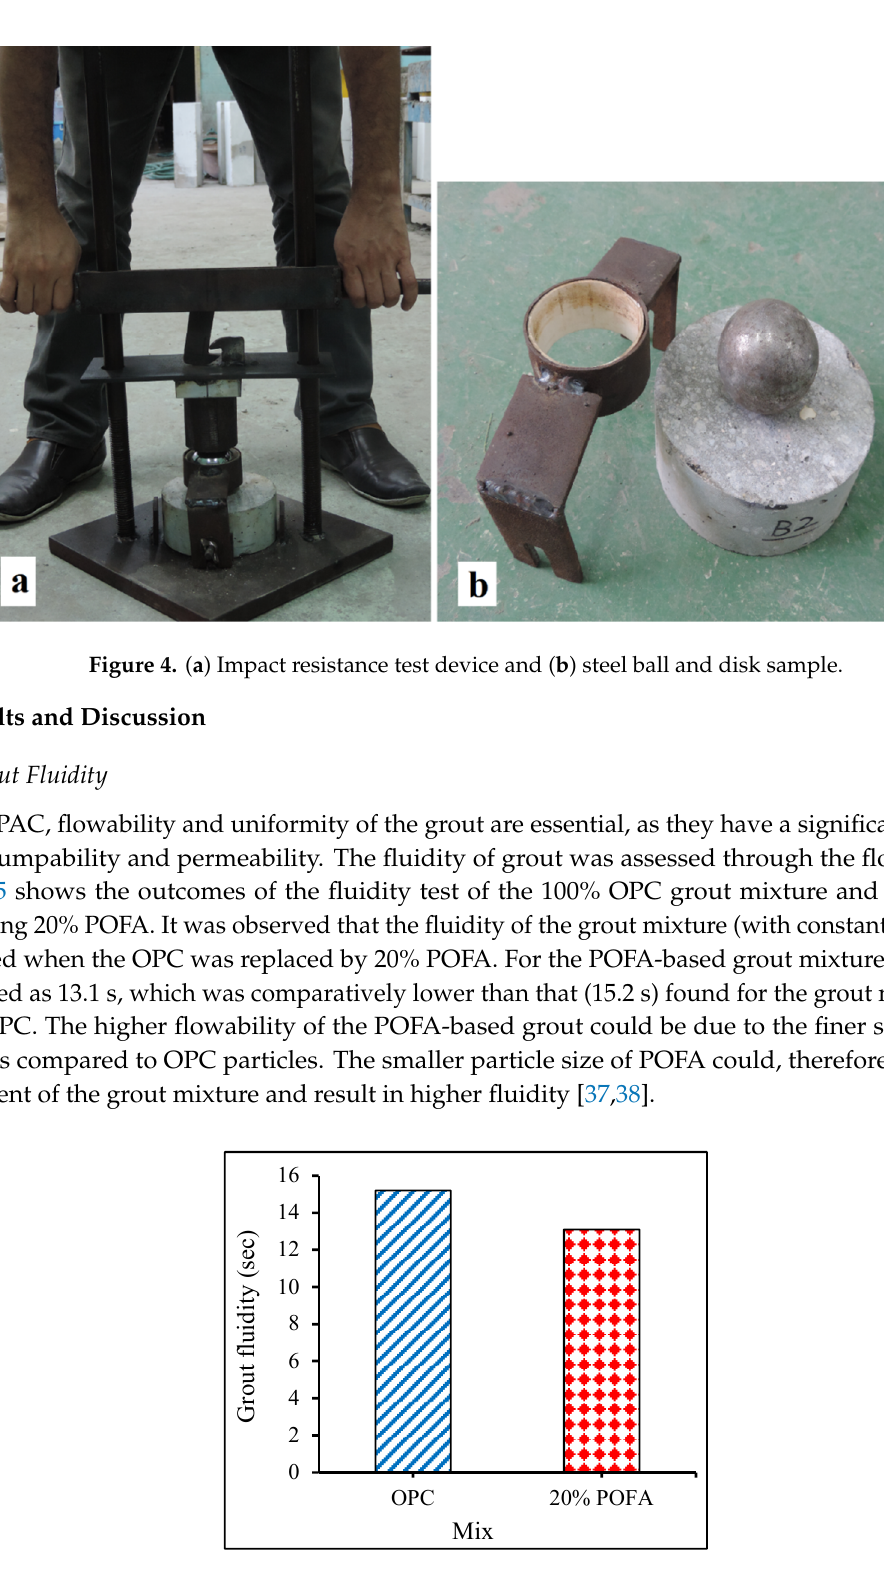
Figure 5. Grout fluidity of the OPC and POFA grout mixtures.